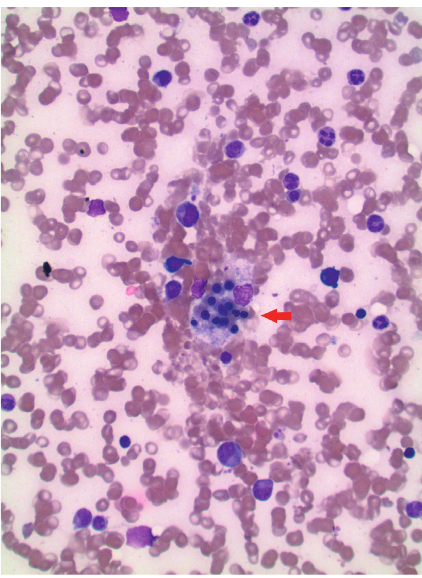
Figure 3: Leishman stain: hemophagocytosis in the bone marrow aspirate smear. The photomicrograph depicts a macrophage in the center of the smear ingesting nucleated red cell precursors.